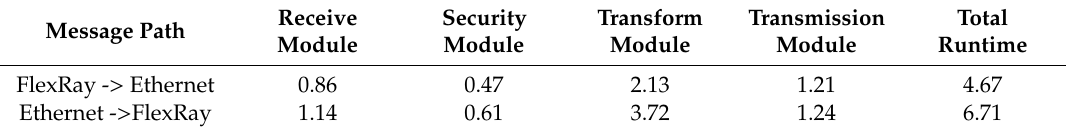
Table 7. Detail for execution time ( µ s) of modules within the proposed gateway host.